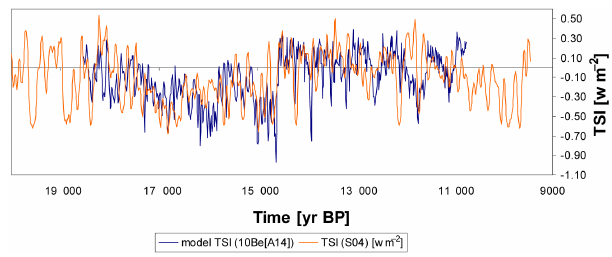
Figure 3. A test of the recurrent TSI signal based on 14 C over the last 11000 years, TSI(S04), and the linear model based on the 10 Be isotope concentration record from Greenland ice cores. We extrap- olated the TSI(S04) record backward in time, 9400 years, to match the model based on 10 Be isotope (A14) that covers the period from 18000 to 10000